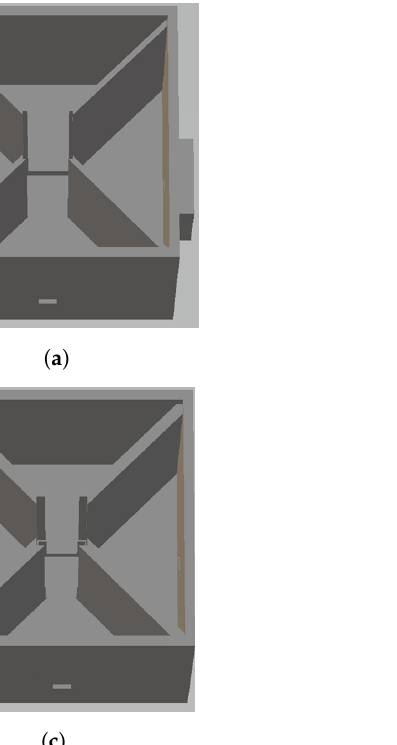
Figure 6. Square cuvette sample holder designs with a light-to-frequency converter at 90 ◦ from the IR LED as well as the results from validation tests. ( a ) Initial square design. ( b ) Frequency output for initial square sample holder. ( c ) Revised square sample holder with thicker walls and tighter fit to cuvette. ( d ) Frequency output for revised square sample